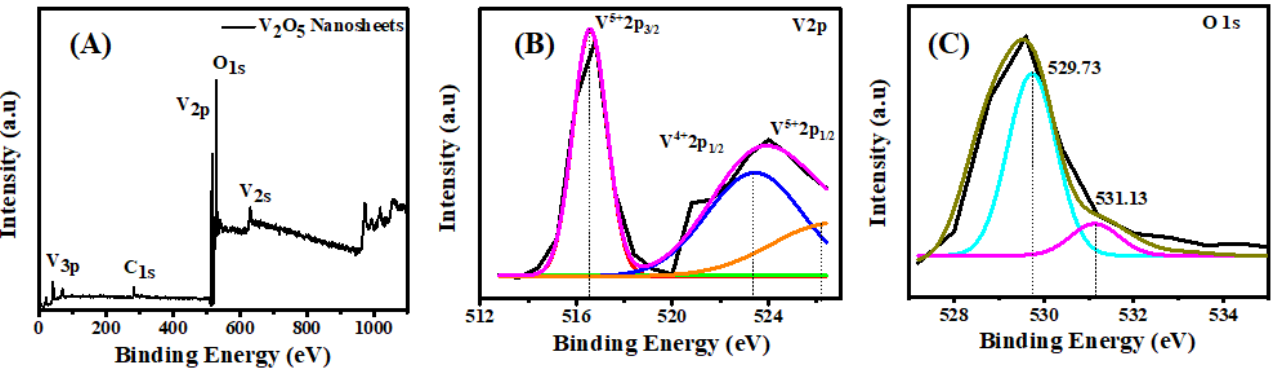
Figure 7. ( A ) Wide binding energy, ( B ) core level V 2p , and ( C ) core level O 1s of XPS spectrums of V 2 O 5 nanosheets.